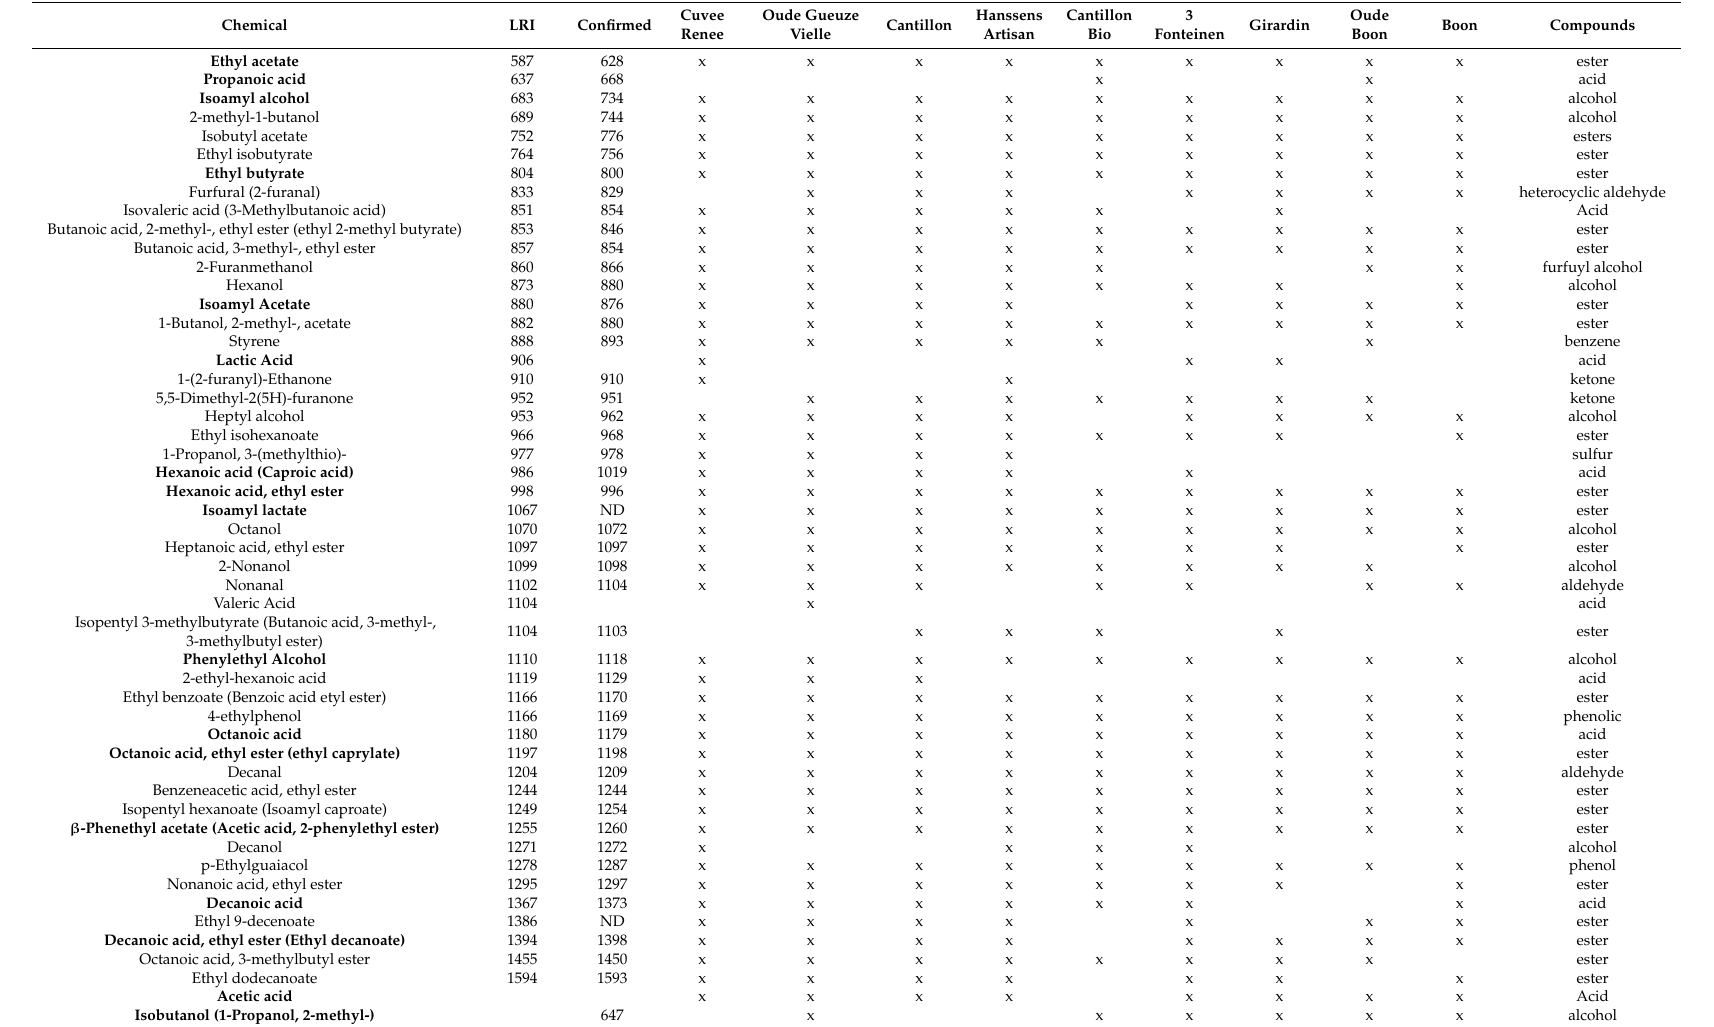
Table 4. Chemicals identified within the commercial